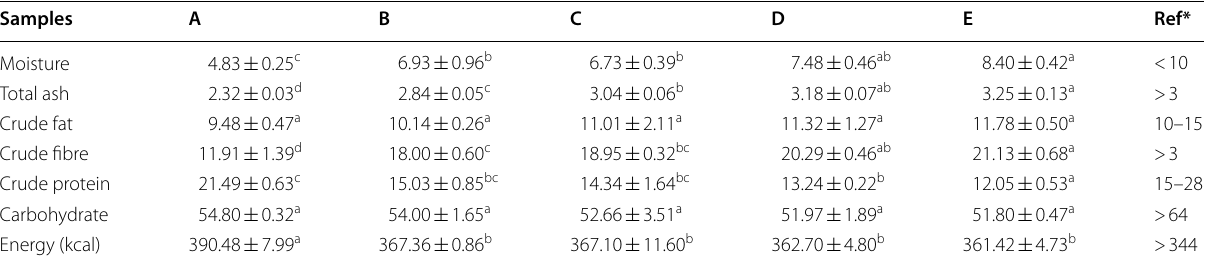
Table 2 Proximate composition (%) and energy value of corn silk–lemon blends (dry weight basis)